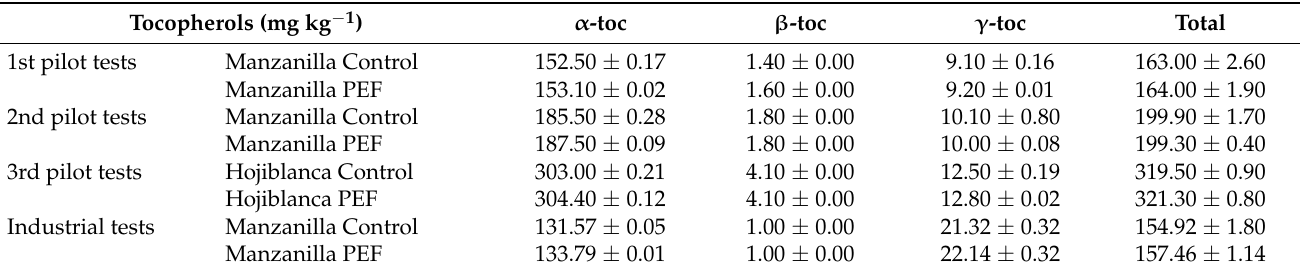
Table 6. Tocopherols content (mg kg − 1 ) in control and PEF oils obtained from ‘Manzanilla’ and ‘Hojiblanca’